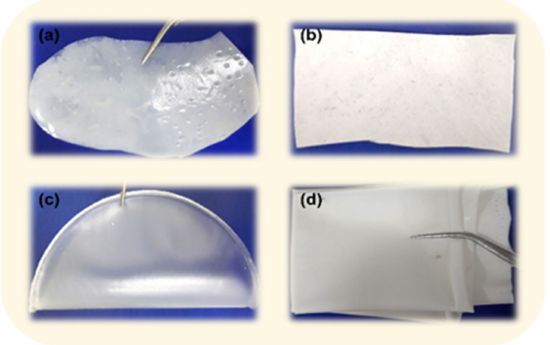
Figure 1. The effect of polyols’ nature on the preparation of the final membranes: ( a ) PESU-based membrane prepared by using dry solution casting method; ( b ) PESU-based membrane prepared by wet solution casting method; ( c ) PETU-based membrane prepared by dry solution casting method; ( d ) PETU-based membrane prepared by wet solution casting